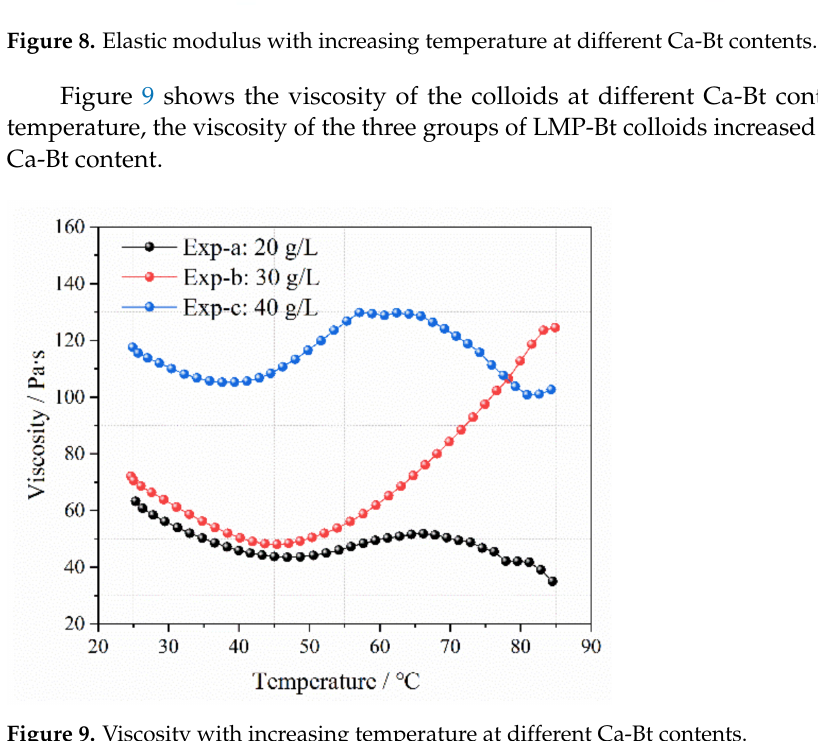
Figure 8. Elastic modulus with increasing temperature at different Ca-Bt contents.